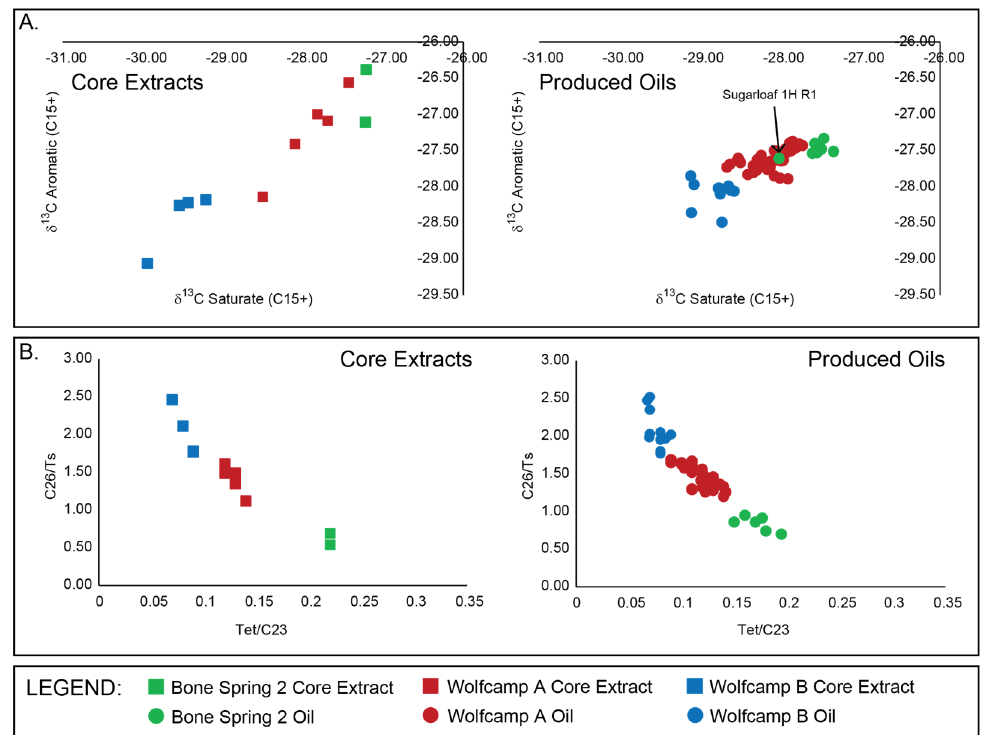
Figure 6. Depth cross ‐ plots for the 15 extracted hydrocarbon samples analyzed in the Delaware Basin case study. The depth range for the stratigraphic formations (Bone Spring 2, Bone Spring 3, Wolfcamp A, B and C) are highlighted. The red circles in the plots highlight samples with similar geochemical signatures across formations while the red arrows highlight distinct geochemical differences of sample extracts within formations. Detailed assessment of this information points towards some inter ‐ formational (as well as intra ‐ formational) migration and mixing, influencing the signatures preserved. ( A ) (S1/TOC)*100 ratio calculated from Total Organic Carbon (Weight % TOC) and Pyrolysis data (S1 mg HC/g rock). ( B ) Carbon isotope signatures ( δ 13 C VPDB ) of the C15+ saturate fraction. ( C ) Upwelling biomarker ratio C26 S&R tricyclic terpane/C27 pentacyclic terpane Ts (18a, 21b ‐ 22,29,30 ‐ trisnorhopane) ratio (C26/Ts). ( D ) Saturate Fraction relative to Aromatic fraction (C15+) ratio (S/A).